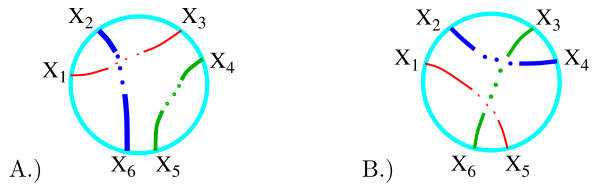
Possible parities.